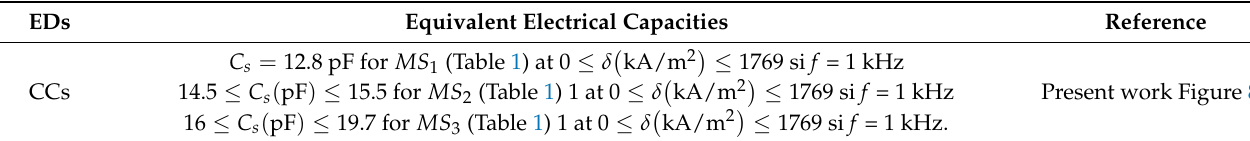
Table 4. Comparative values of equivalent electrical capacities of